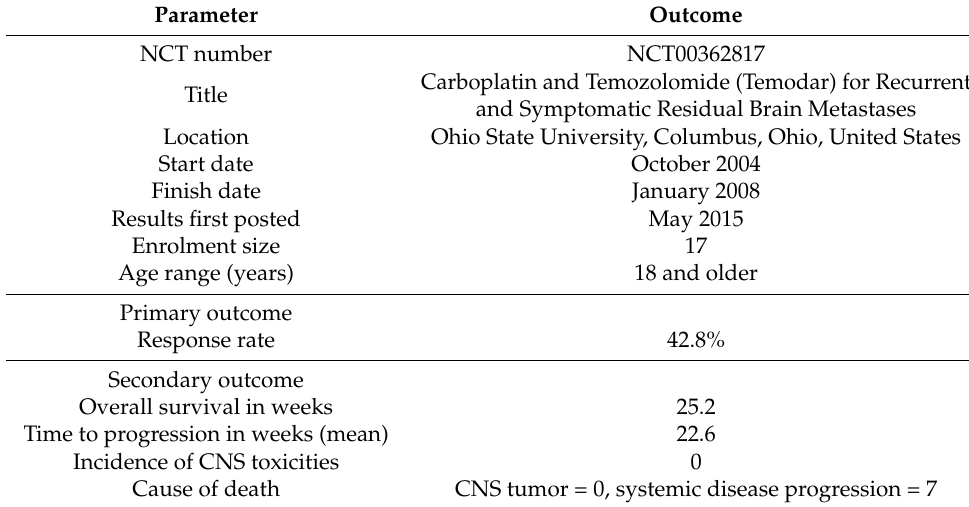
Table 3. Summary of clinical trial with reported